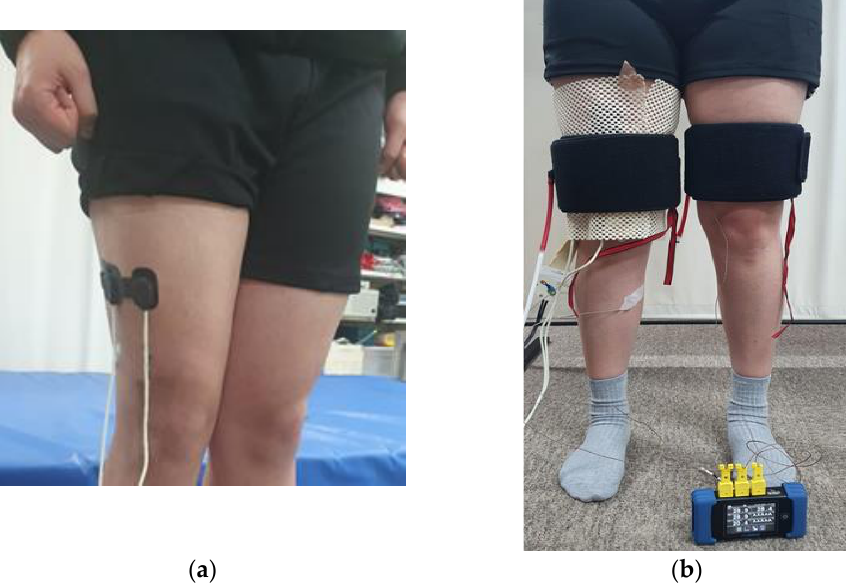
Figure 1. Equipment setting: ( a ) position of NIRS sensor probe; ( b ) experimental equipment attached to the thigh.